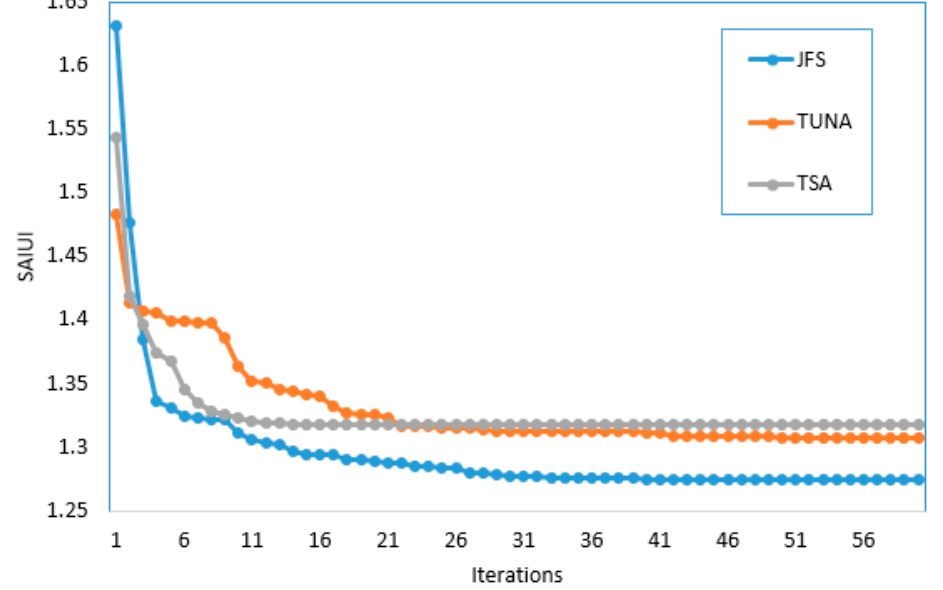
Figure 3. Convergence curves of TUNA, TSA and JFS algorithms for case 1.